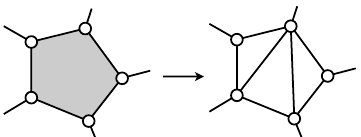
Figure 1. A pentagonal link rewritten as a truss consisting of binary links.